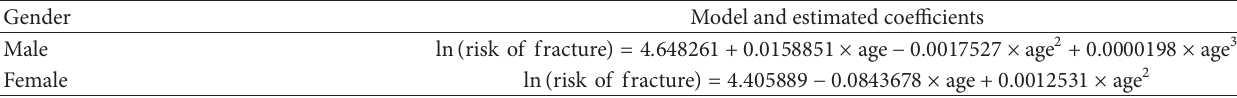
Table 1: log-linear model of age-specific fracture hospitalisation rates.